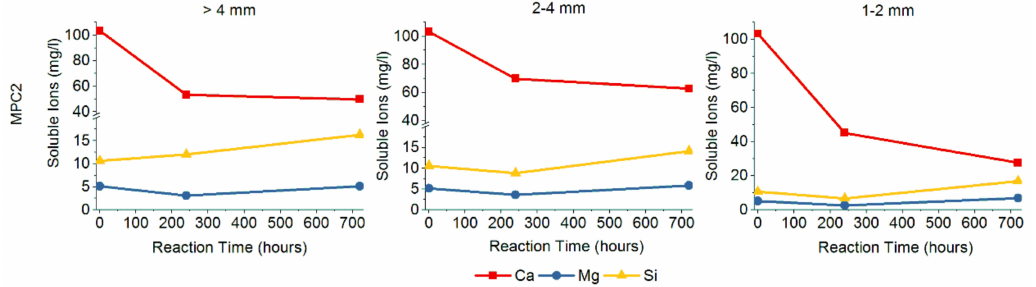
Figure 7. Soluble Ca, Mg, and Si ions measured untreated and treated after 240 and 720 h of reaction for MPC2 (modified from